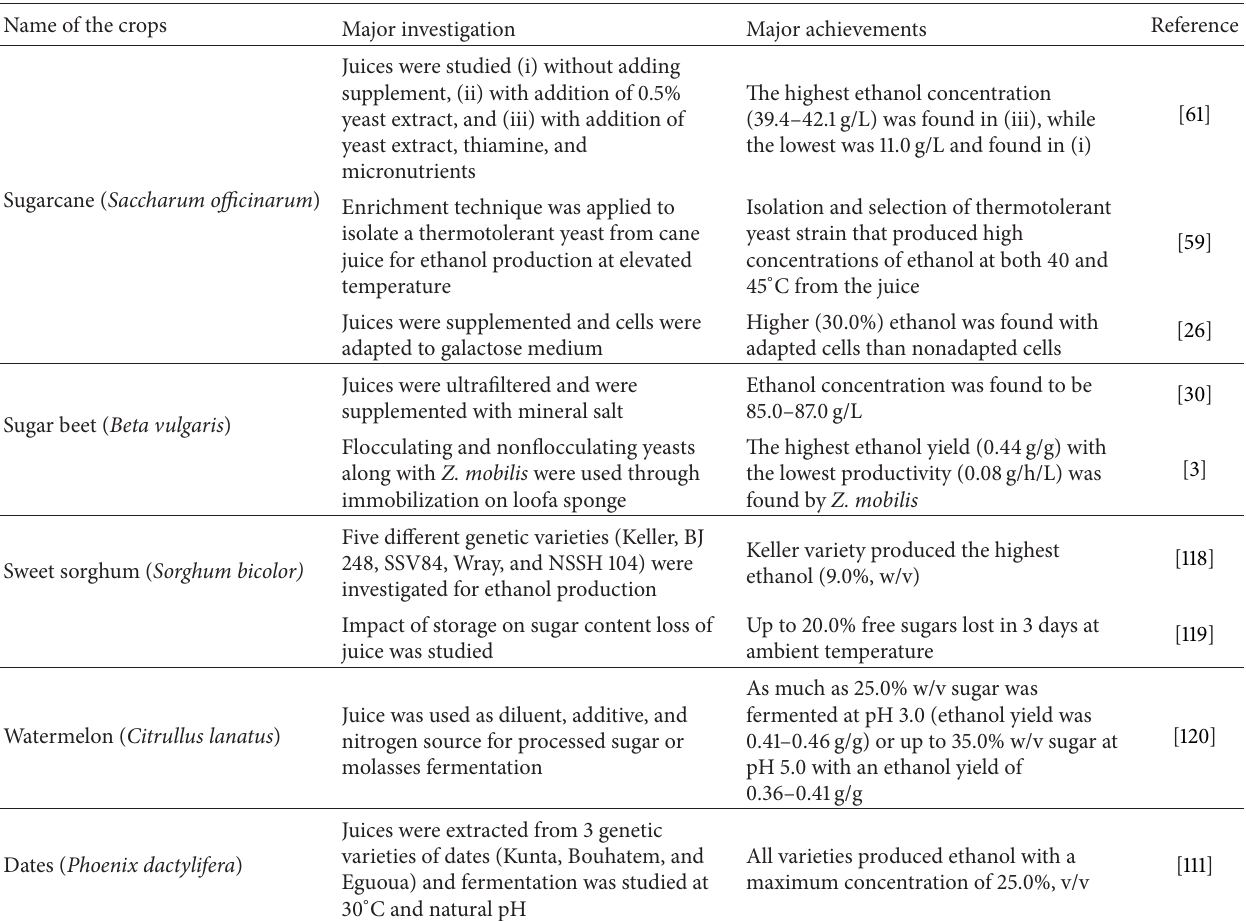
Table 1: Different sugar crops investigated for ethanol production using sugar juices as